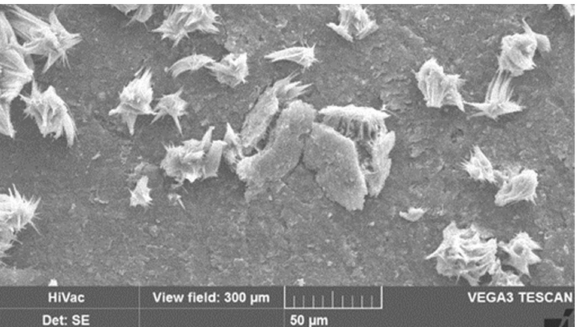
Figure 8. Calcium carbonate induced “crack formation” of loaded specimen (V09 after 8 weeks storage under industrial composting